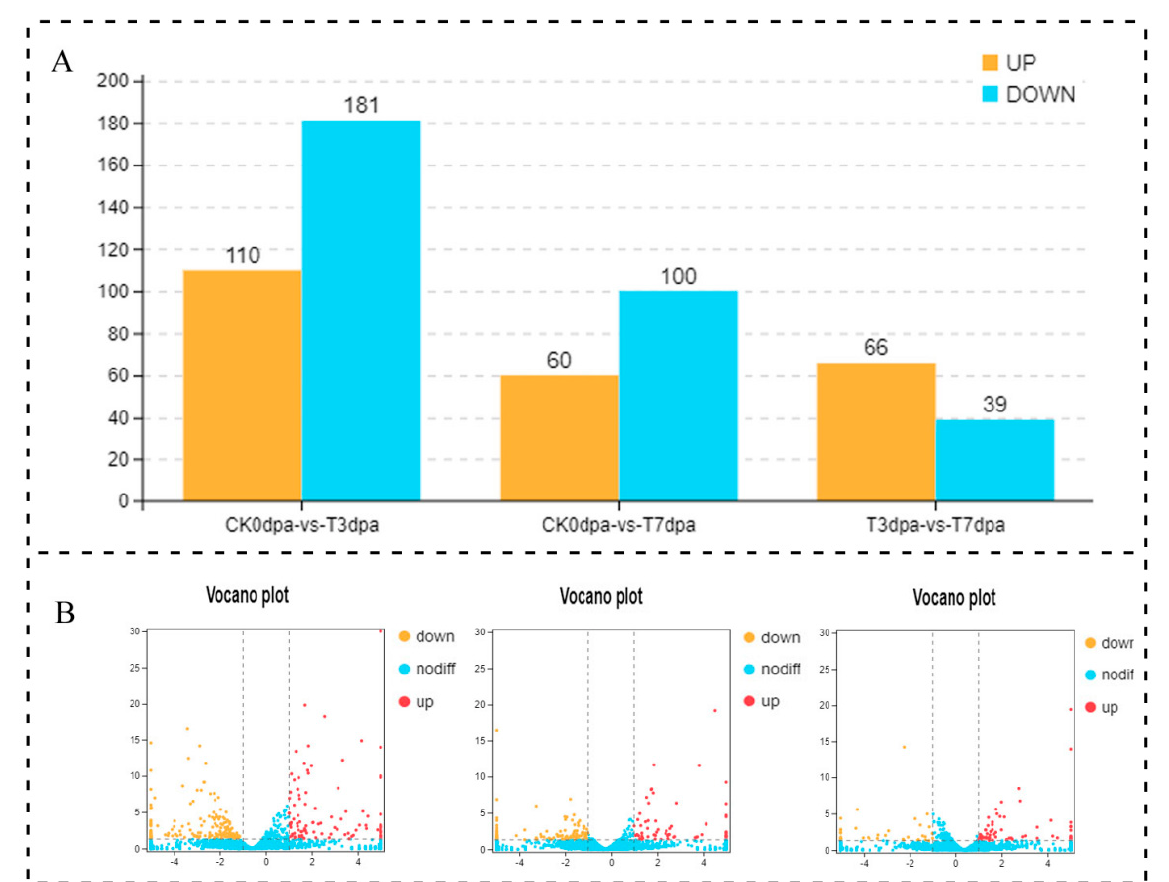
Figure 3. The statistical analysis on the DE lncRNAs at the different stages of caudal fin regeneration. ( A ) The numbers of up-regulated and down-regulated lncRNAs at different regeneration stages are showed in a bar graph. ( B ) The numbers of up-regulated and down-regulated lncRNAs at different regeneration stages are showed in volcano plots. The abscissa represents the logarithmic value of the difference multiple of two samples (CK0dpa vs. T3dpa, CK0dpa vs. T7dpa, T3dpa vs. T7dpa), and the ordinate represents the negative log10 value of the FDR of the two samples. The red (sample − 2 expression is up-regulated relative to sample − 1) and yellow (the expression level is down-regulated) colors indicate that there is a difference in gene expression (judgment criterion was FDR < 0.05, and the difference multiple was more than 2), and the black color indicates no difference. CK0dpa, control group at 0 days post-amputation; T3dpa and T7dpa, caudal fin regeneration at 3 and 7 days post-amputation, respectively.